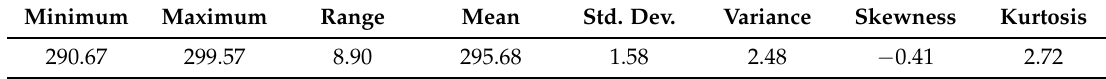
Table A4. Water outlet temperature distribution statistics [K].